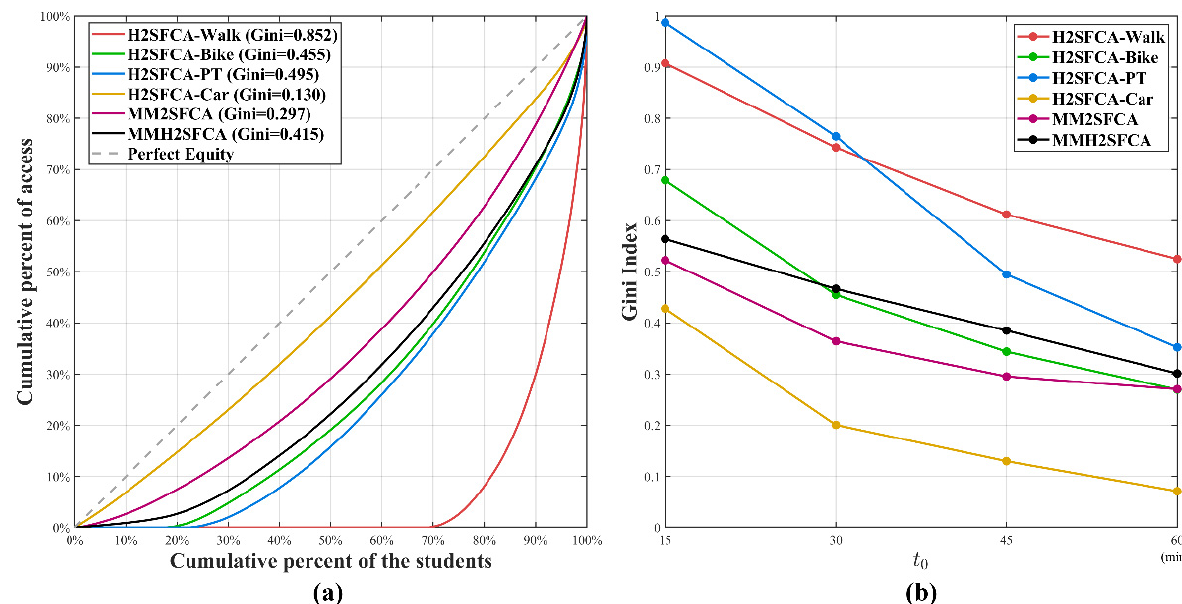
Figure 7. ( a ) Lorenz curves and Gini coefficients corresponding to the results of each method; ( b ) Variation of Gini coefficients with different methods and search radii.